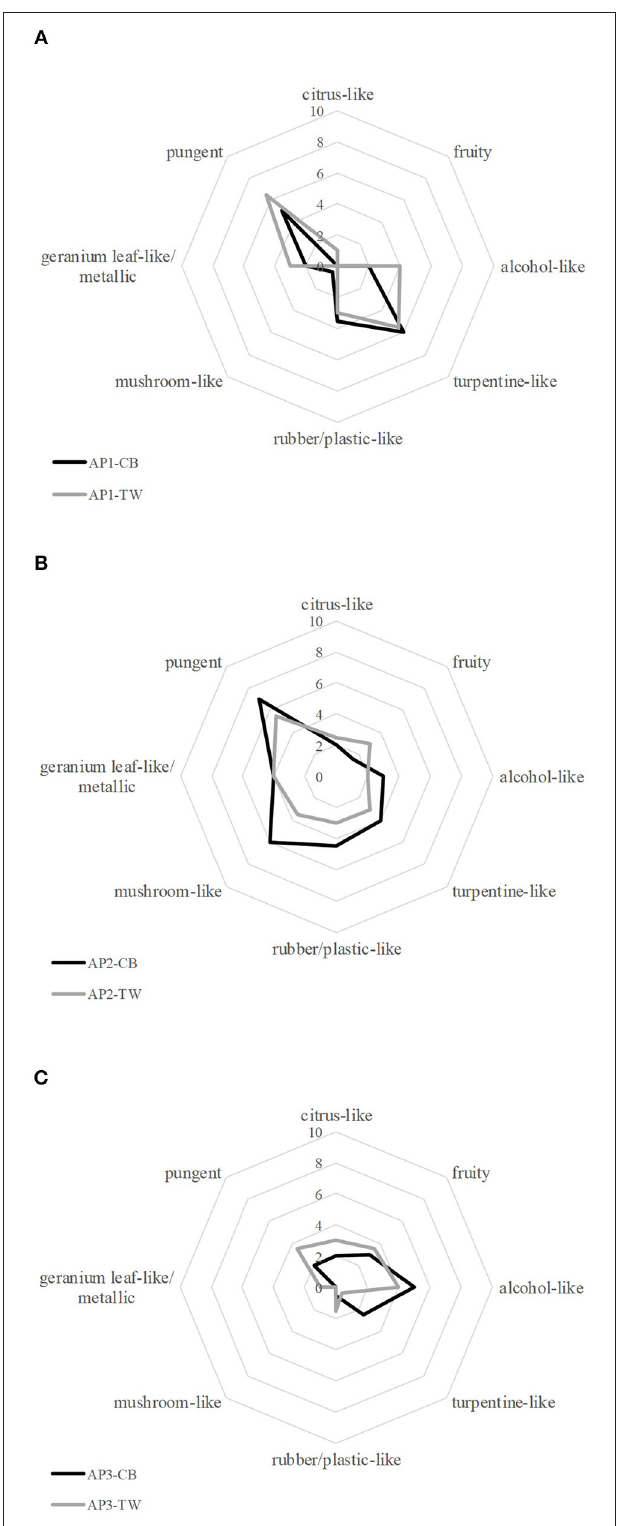
FIGURE 1 | Comparative Odor profile of black (CB) and white (TW) acrylic paints (AP) from each manufacturer respectively [ (A) : AP1, (B) : AP2, (C) :